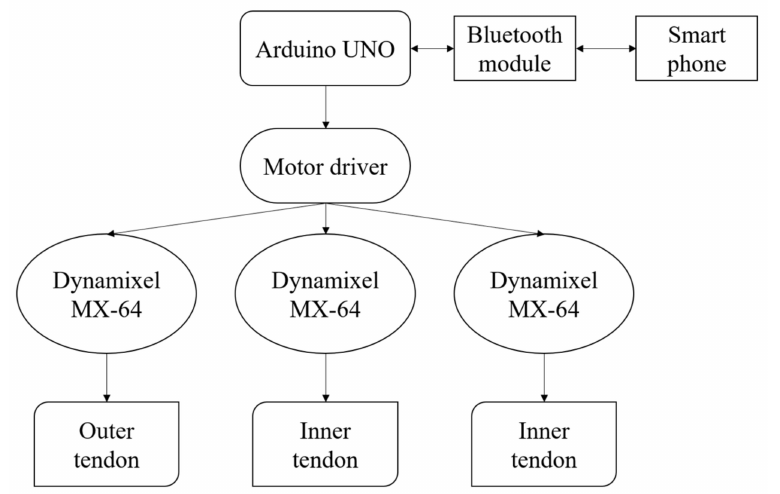
Figure 5. Diagram of the control system for the